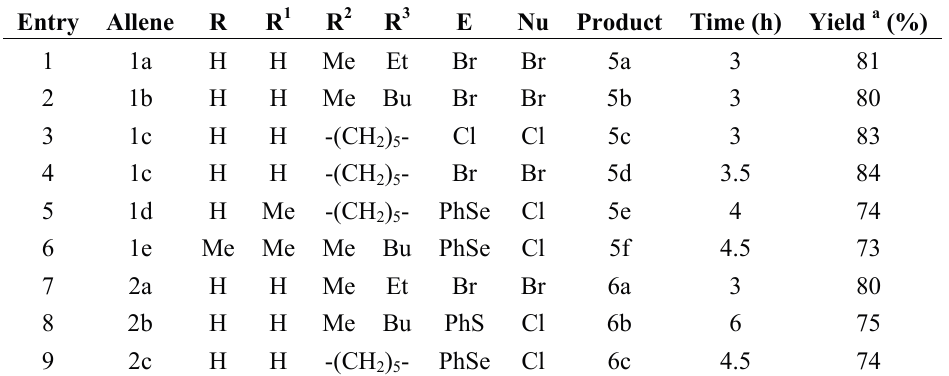
Table 2. Synthesis of the 2-methoxy-2-oxo-2,5-dihydro-1,2-oxaphospholes 5 and 6